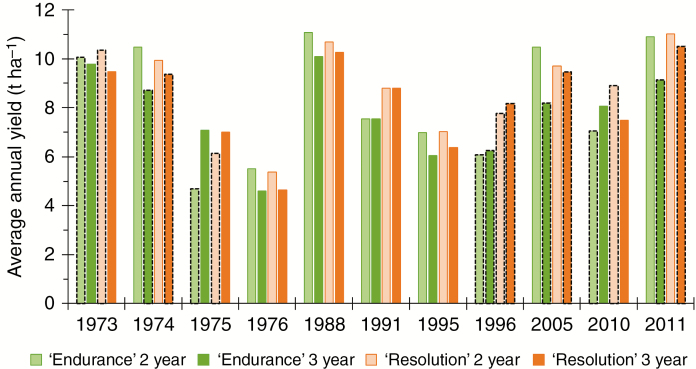
Average simulated annual yields for willow cultivars ‘Endurance’ (green) and ‘Resolution’ (orange) and 2-year (light colour) and 3-year (dark colour) growth cycle management on marginal soils (SAWC <100 mm) at two weather stations in the SE of the UK for drought years as defined by the UK Meteorological Office. Black dashed borders represent the first year of a growth cycle.